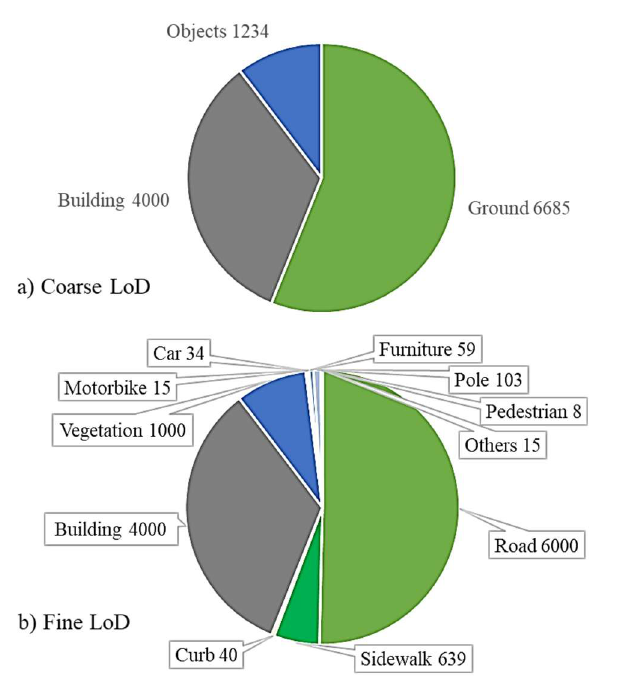
Figure 5: Distribution of classes in thousands of